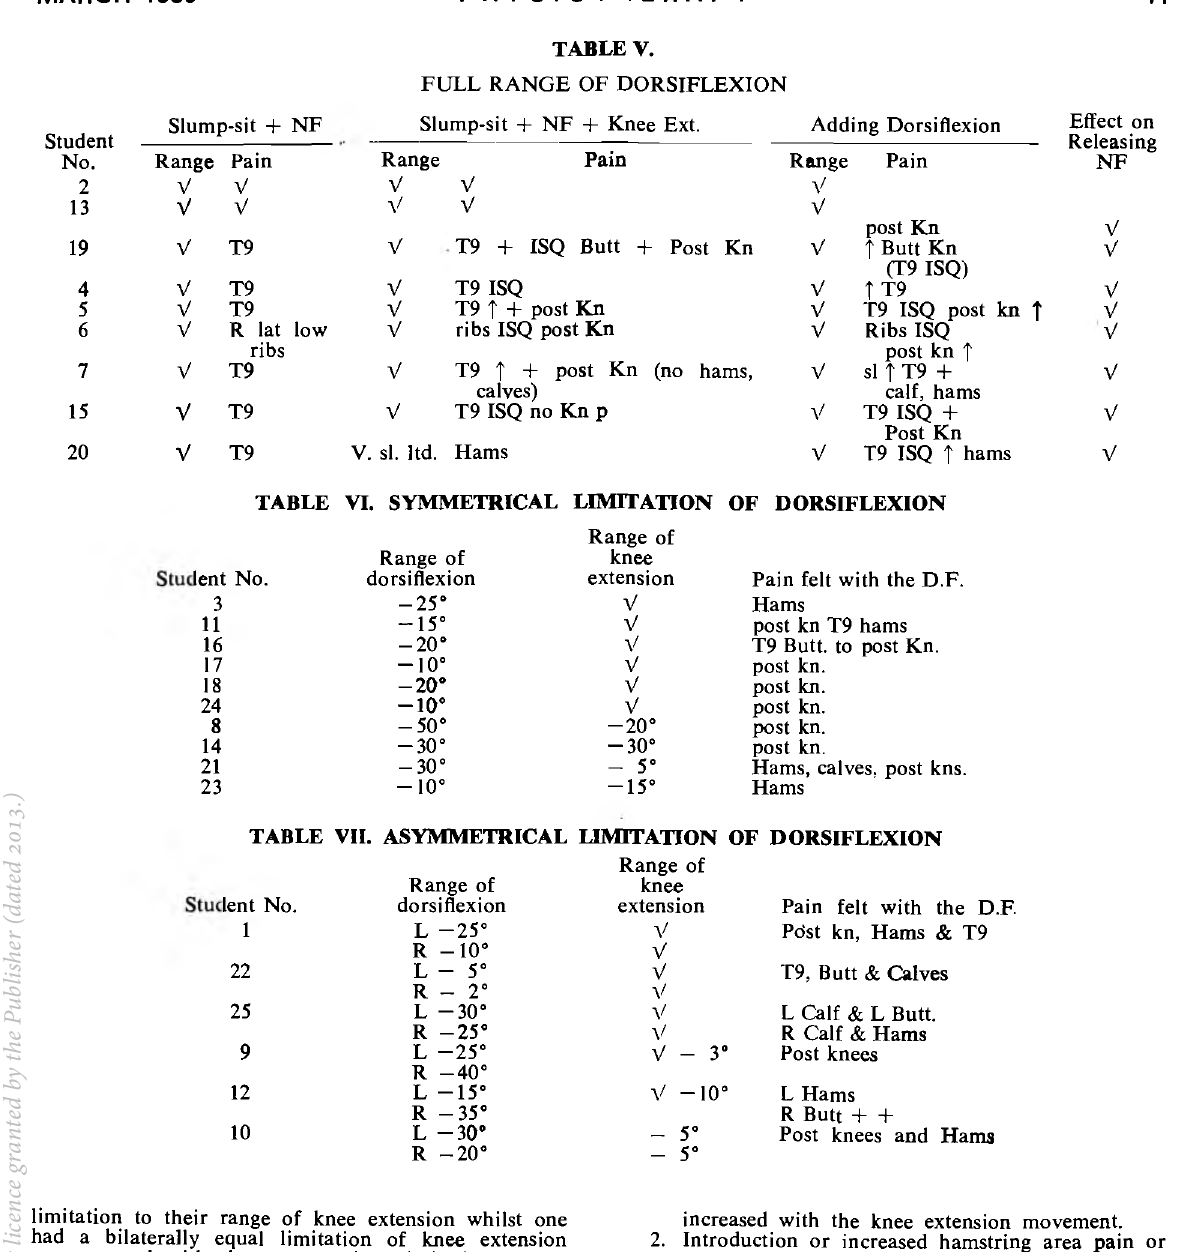
TABLE V. FULL RANGE OF DORSIFLEXION